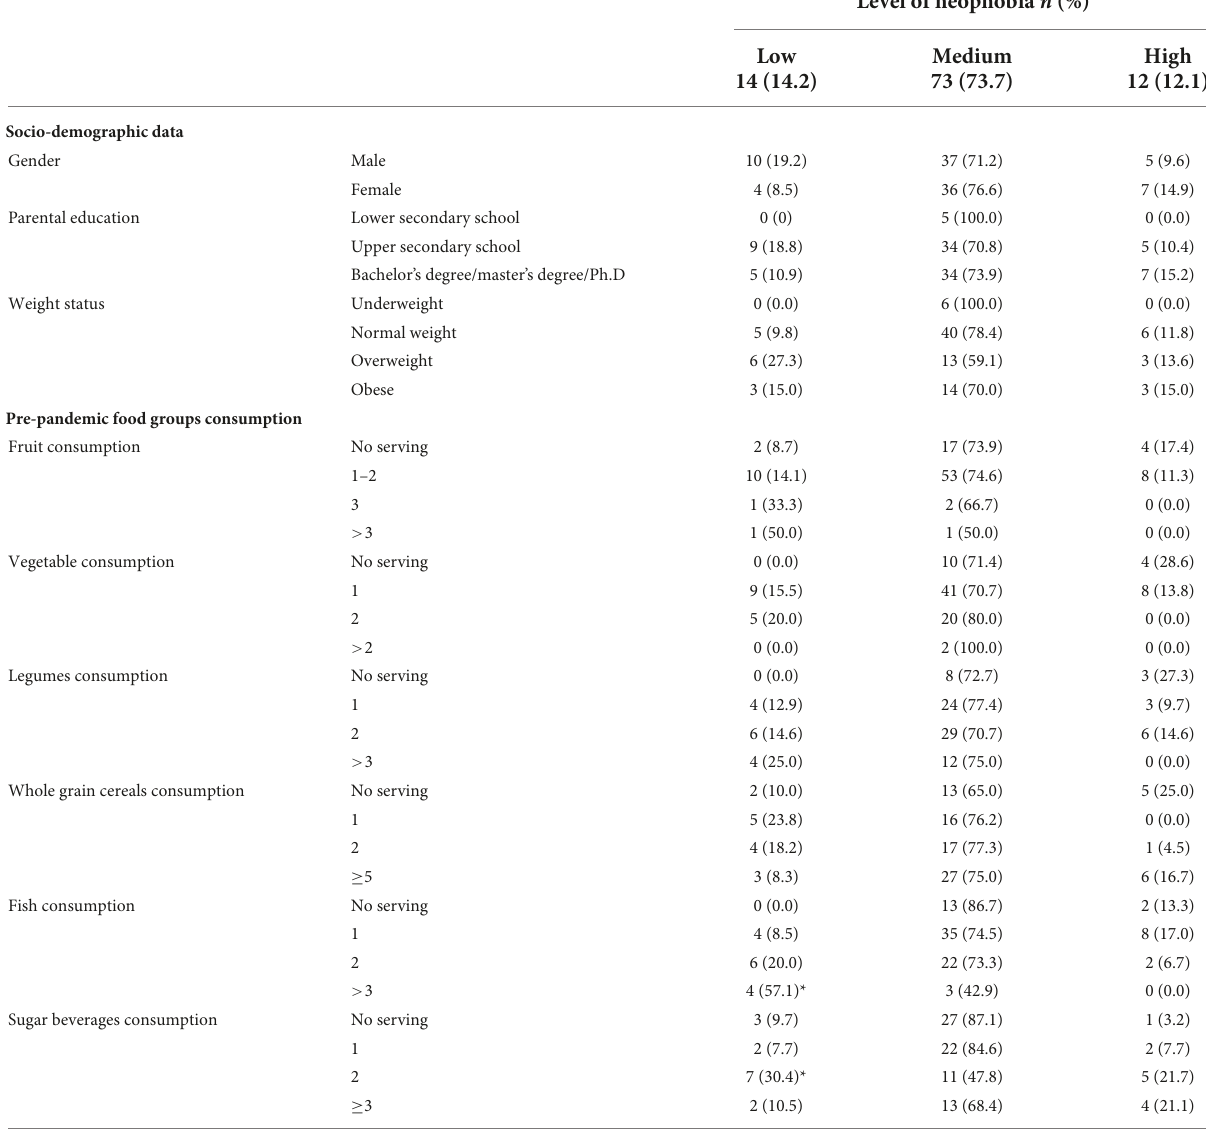
TABLE 4 The relationship between the level of neophobia and socio-demographic data, pre-pandemic food group consumption, n and percentage